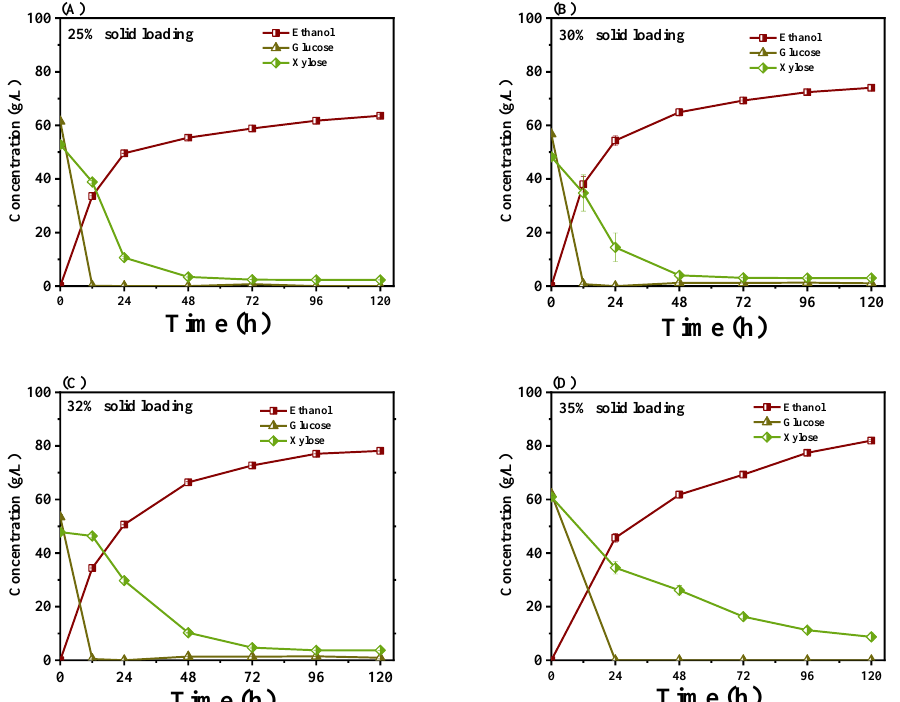
Figure 5. SSCF of DLCA(sa)-CC at different solids loadings. ( A ) 25% solid loading; ( B ) 30% solid loading; ( C ) 32% solid loading; ( D ) 35% solid loading. DLCA(sa)-CC was pre-hydrolyzed for 12 h at 50 °C, 250 rpm, and pH 4.8 with an enzyme dosage of 15 mg protein/g glucan. SSCF with S. cerevisiae CRD5HS (initial OD 600 = 2) was conducted at 30 °C, 150 rpm, and pH 5.5 for 120 h. With the increase in solid loading, SSCF sugar conversions gradually decreased, es- pecially glucan conversion (Table 2). The reason for the decreased sugar conversion was likely caused by the inhibition of increased concentrations of ethanol and degradation products, as well as reduced enzyme activities (as SSCF was conducted under fermenta- tion conditions). Sugar consumptions (94.7 – 98.3%) and ethanol yields (90.9 – 94.5%) were both higher during SSCF compared with those for SHCF (Table 2). The highest concentra- tion of ethanol by SSCF reached 81.99 g/L at 35% solid loading. SSCF has been widely applied for enhancing ethanol yield. For instance, Su et al. applied a fed-batch SSCF strat- egy on corncob and increased the final ethanol concentration to 60.5 g/L at 25% solid load- ing [40]. Yuan et al. obtained a high ethanol titer of 74.6 g/L on corn stover by developing a SSCF strategy of “Fed - batch of DLC Biomass and Enzyme (FBE)” [16]. FBE-SSCF was also used for high solid loading saccharification and fermentation in the present study, which contributed to the high ethanol yields. Table 2. Sugar conversions and fermentation performances for SSCF of DLCA(sa)-CC.